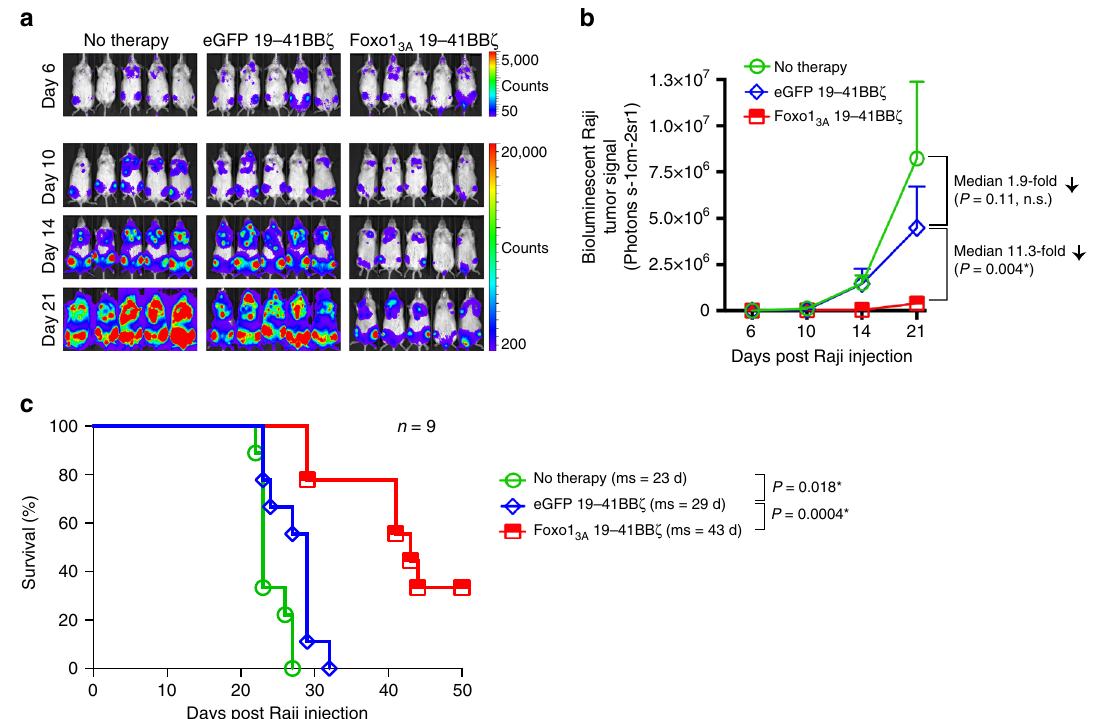
Fig. 5 Foxo1 3A -NP-transfection improves the anti-cancer activities of CAR T-cells. NSG mice were inoculated with CD19 + Raji-luc tumor cells. After 7 days the mice were injected with luciferin and imaged on an IVIS before being randomly sorted into groups ( n = 9) with representative tumor burden. Next 2.5 × 10 6 CD8+ 19-41BB ζ CAR + T-cells (transfected with NPs loaded either with Foxo1 3A mRNA or GFP mRNA) were infused intravenously. Control mice received no treatment. a Representative IVIS imaging depicting fi ve mice per cohort. b Quanti fi ed tumor burden (as mean radiance from luciferase activity from each mouse from a ± SE). Pairwise differences between groups were analyzed with the unpaired, two-tailed Student ’ s t Test; n.s., non-signi fi cant; *, signi fi cant. c Kaplan – Meier survival curves for treated and untreated control mice. Shown are nine mice per treatment group pooled from two independent experiments. ms, median survival. Statistical analysis between the treated experimental and the untreated control group was performed using the Log-rank test; P < 0.05 was considered signi fi